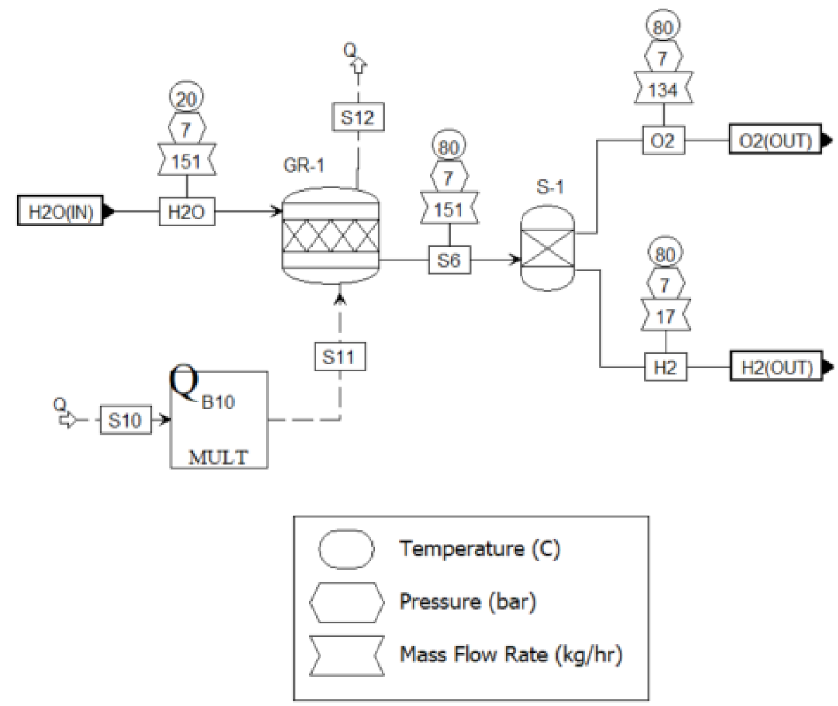
Figure 3. Flowsheet of the PEM